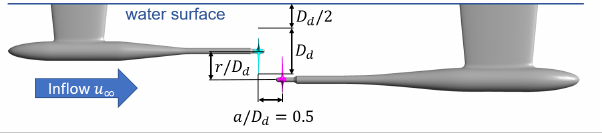
Fig. 1. Geometry of double turbine configuration. Radial distance in shown example r/D d = 0 . 6 .